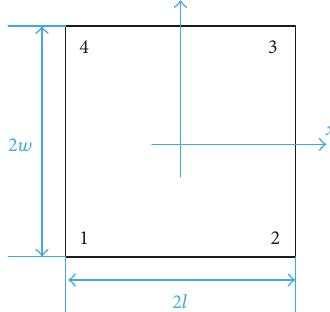
Figure 3: Schematic diagram of boundary